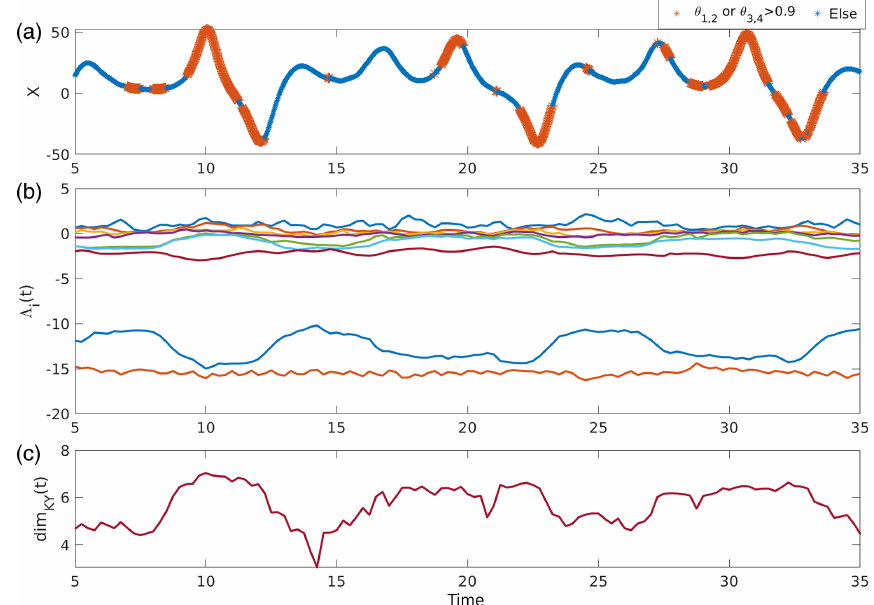
Figure 5. Local dynamical properties of a segment of an example model run. (a) Alignment of CLVs associated with the unstable and neutral subspaces plotted along the x coordinate of the ocean subsystem. Large orange stars indicate high alignment of unstable or neutral CLVs ( θ 1 , 2 > 0 . 9 or θ 3 , 4 > 0 . 9). (b) Time-varying FTLEs (cid:51) i (t) computed over window τ = 4. (c) Local Kaplan–Yorke dimension calculated from FTLEs.